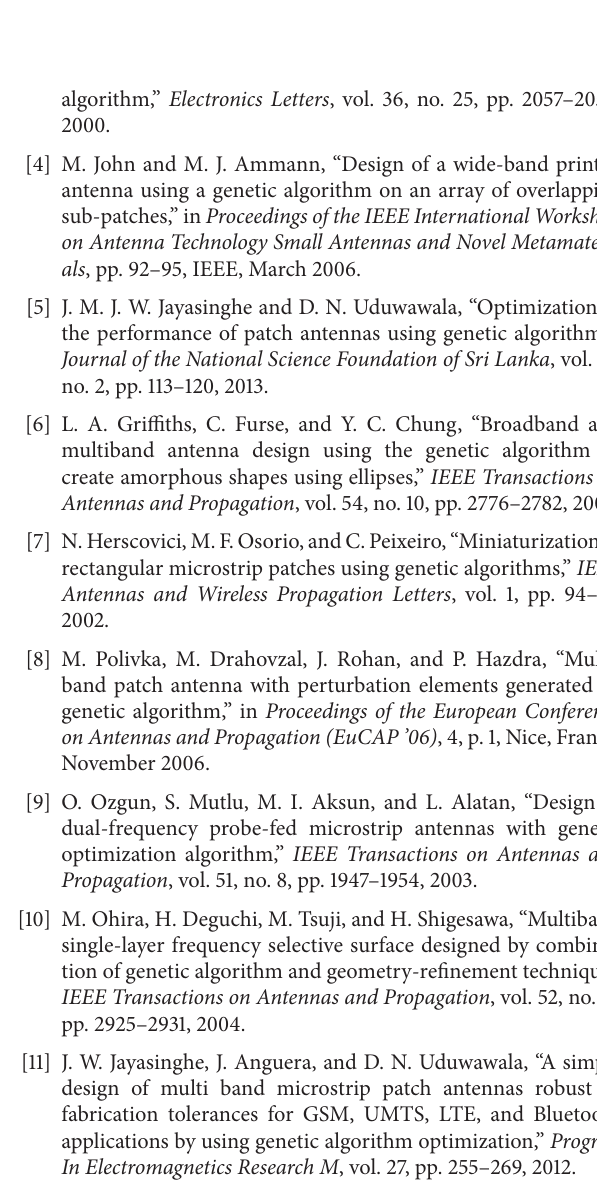
Figure 9: Current distribution at resonant